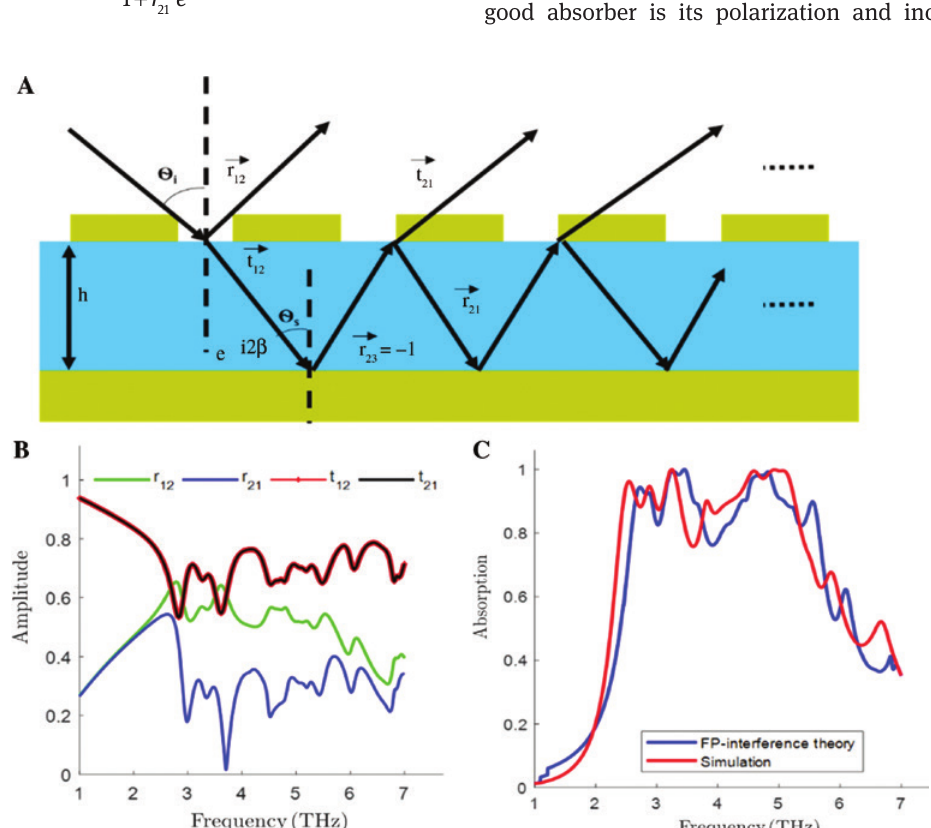
Figure 9: Multiple reflection and interference theory mechanism. (A) Fabry–Perot cavity model of our proposed supercell design at h = 11 μ m based on interference theory. (B) Simulated magnitude of the complex coefficients of transmission and reflection at the interface. (C) Numerical results of absorption of broadband supercell design obtained from simulation and Fabry–Perot interference